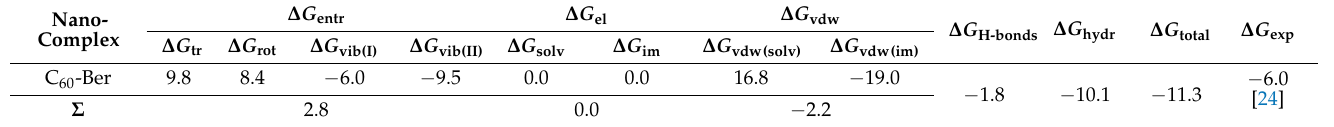
Table 2. Energy terms ( ∆ G, kcal/mol) of C 60 complexation with Ber molecule. Nano-